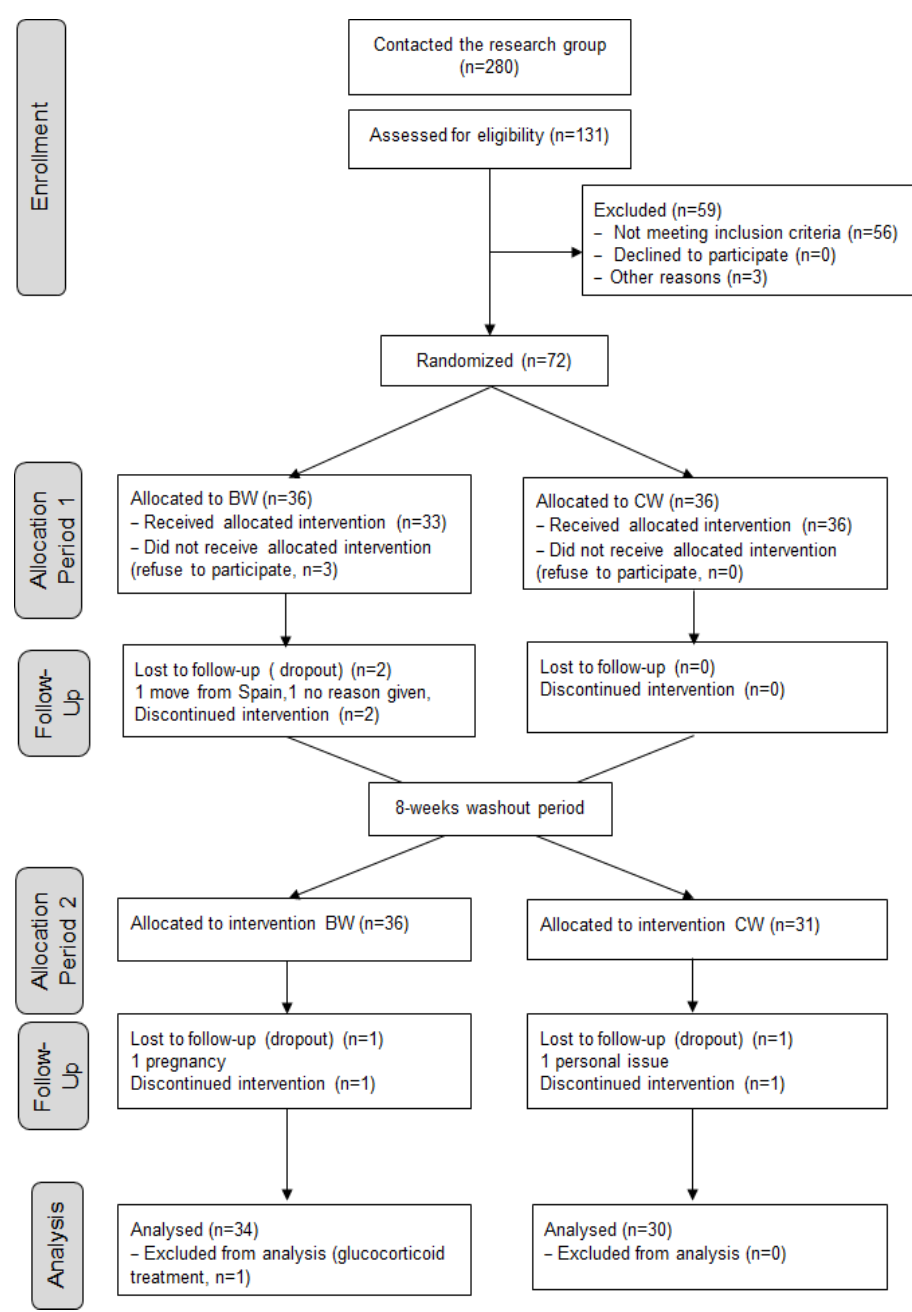
Figure 1. CONSORT flow diagram showing number of participants through each stage of the randomised crossover trial.